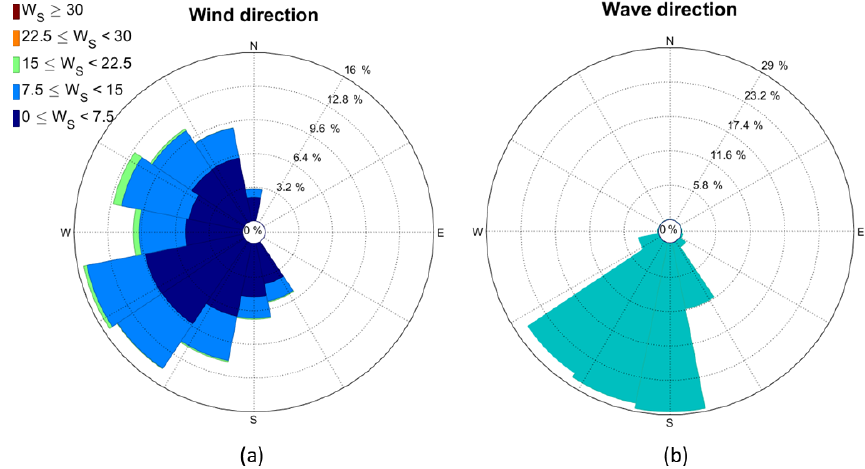
Figure A1. (a) The wind rose is shown excluding the wind shadow zones at z = 18m, while in (b) the peak wave direction is shown. Data correspond to the ASIT measurement mast (65128 measurement points) during the 2003–2012 period.